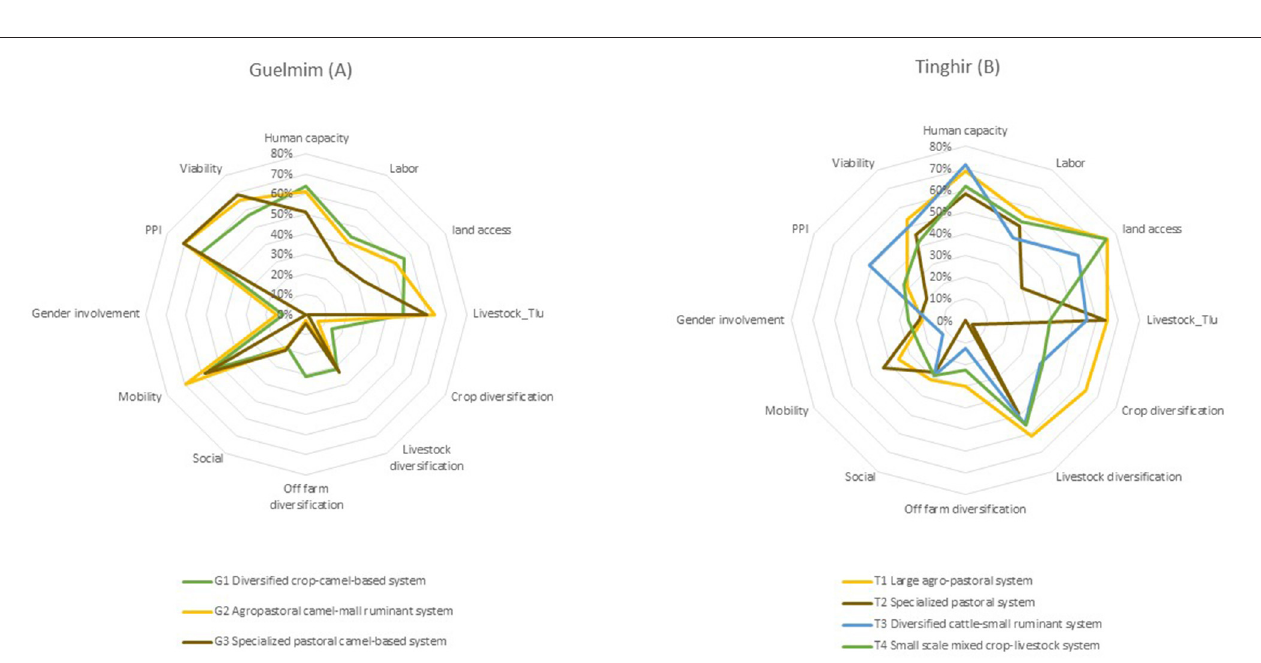
FIGURE 4 | Profiles of resilience for each agropastoral and pastoral systems by distinguishing camel-based systems in Guelmin (A) and sheep and goats-based systems in Tinghir (B) (PPI: Progress Out of Poverty Index).